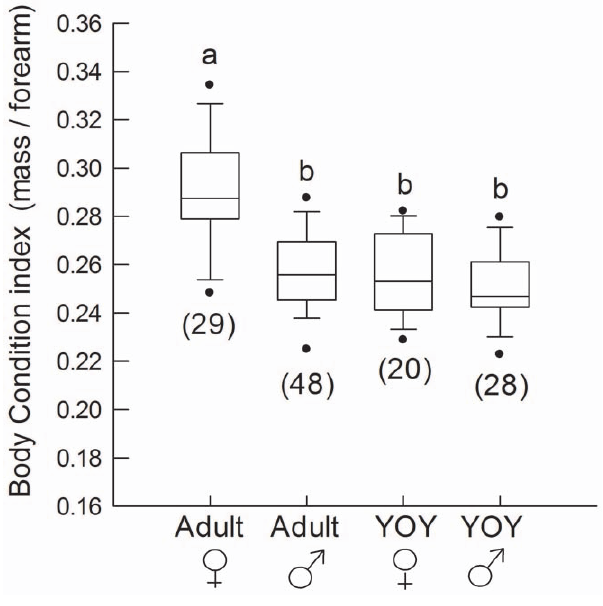
Figure 2. Body condition indices of bats during early hiberna- tion. Bats were captured on 28, 29 Nov 2009 in Dale’s, Firecamp and Microwave caves. Numbers in brackets indicate sample size and boxes sharing the same letter are not significantly different from each other. Boxes depict the 25 th and 75 th percentiles, lines within boxes mark the median, whiskers represent 95 th and the 5 th percentiles and dots indicate outliers.